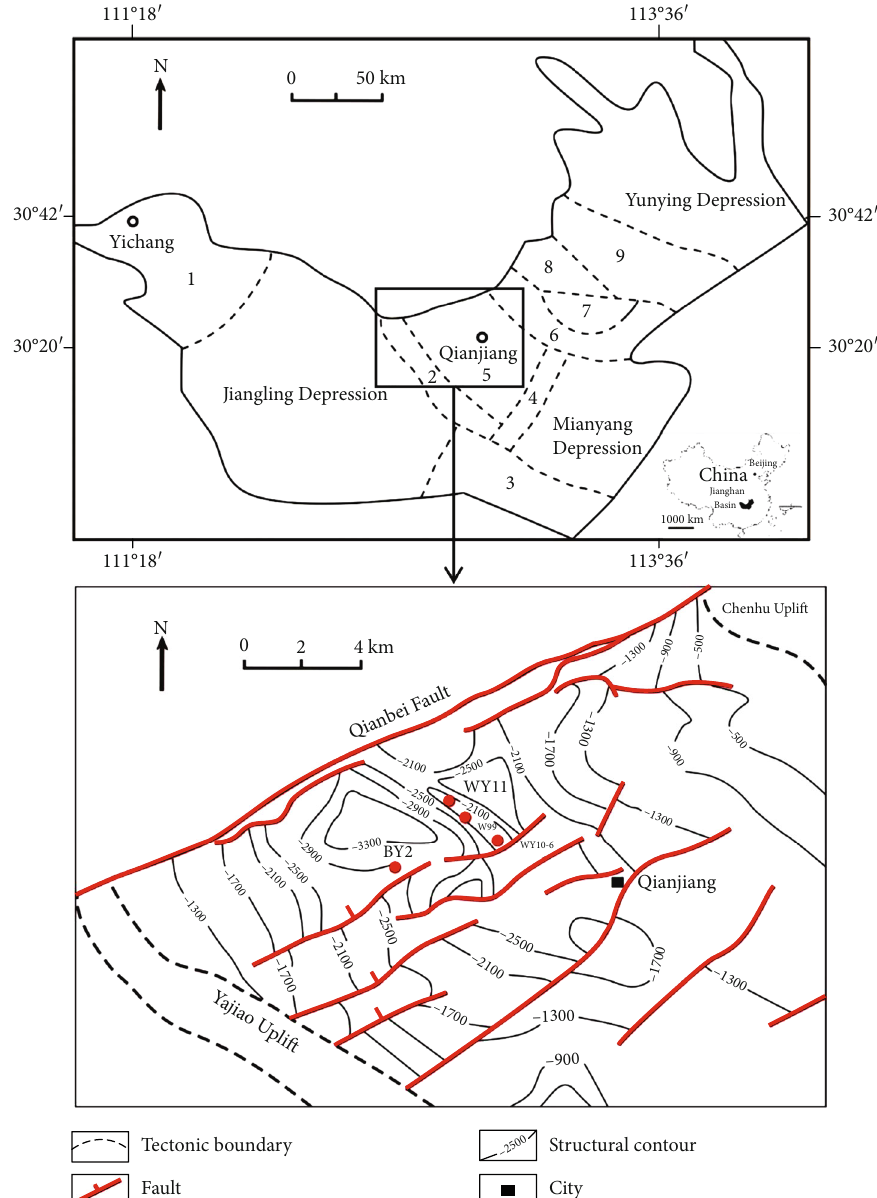
Figure 1: The structure of the Qianjiang Depression in the Jianghan Basin. 1: Zhijiang Depression; 2: Yajiao Uplift; 3: Chentuokou Depression; 4: Tonghaikou Uplift; 5: Qianjiang Depression; 6: Chenhu Uplift; 7: Xiaoban Depression; 8: Tianmen Uplift; 9: Longsaihu